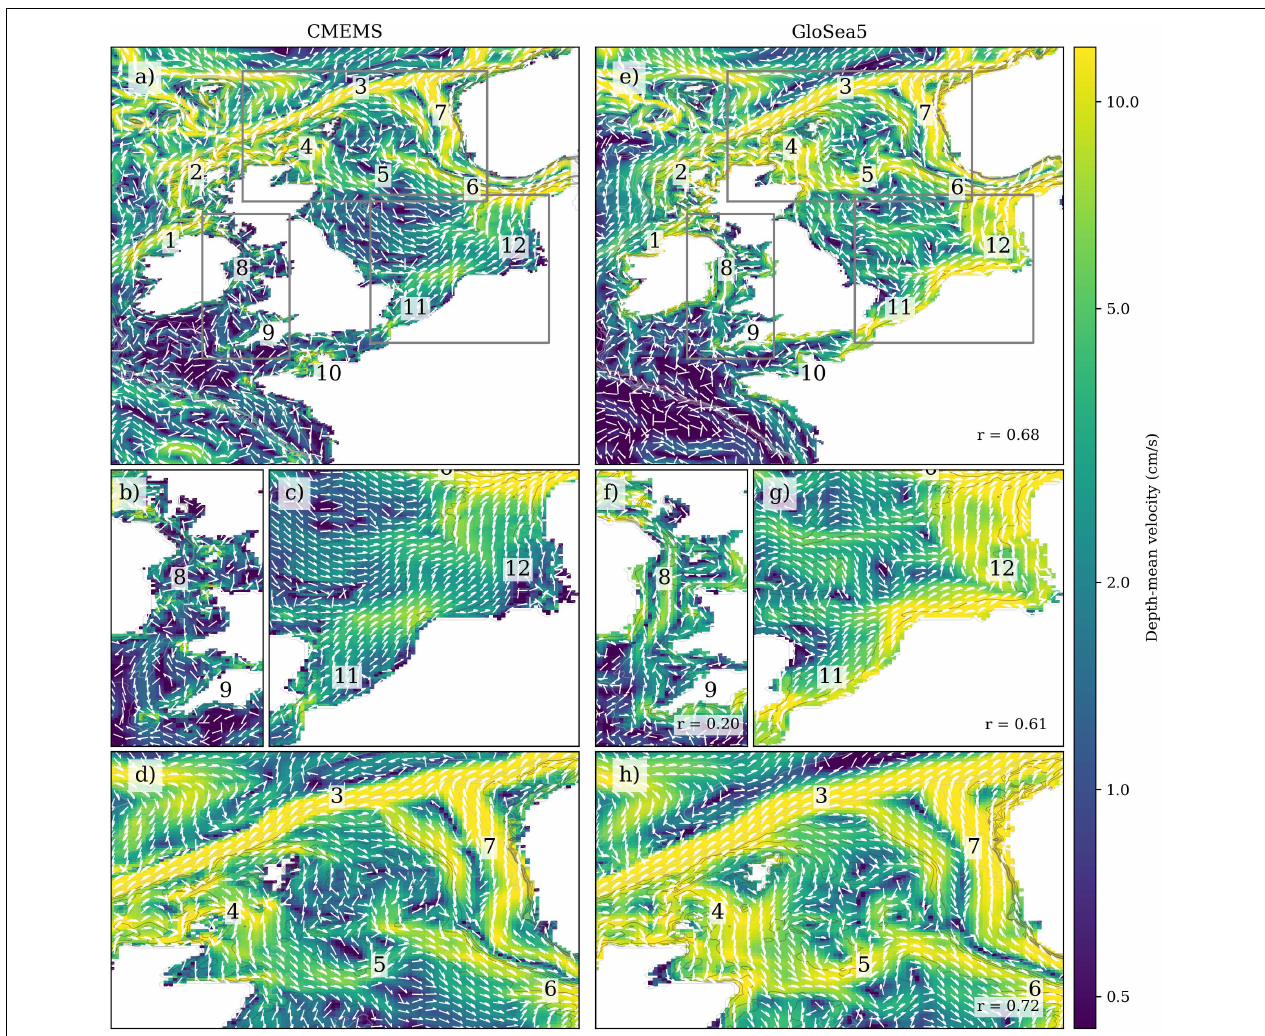
FIGURE 2 | Circulation of CMEMS (a–d) and GloSea5 winter depth-mean climatology (e–h) . The arrows show the direction of the currents, and the colouring shows the current magnitude (cm/s, note the colouring on a logarithmic scale). An overview of the NWS circulation is given in panel (a,e) . Further (zoomed) details of important regions are given in panels (b–d,f–h) , which correspond to the grey boxes in the upper panels (a,e) . The spatial correlation of the depth mean current magnitude between each pair of panels is given in (e–h) . This is only calculated from grid boxes within each panel, that are within the NWS. The equivalent plots showing salinity (and temperature) distribution for the average of 2010/2011 and 2011/2012 are given in Supplementary Figures 5 , 6 , to show the relationship between advection and tracer distribution. Figure 8 compares the depth mean circulation of CMEMS and CO6 averaged over the 2010/2011 and 2011/2012 winters. Relevant NWS circulation features are numbered and described in Box 1